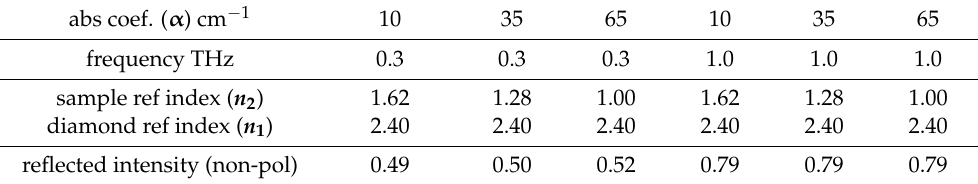
Table 2. The estimated reflectance of liquid water and ice with S, P and non-polarised THz radiation